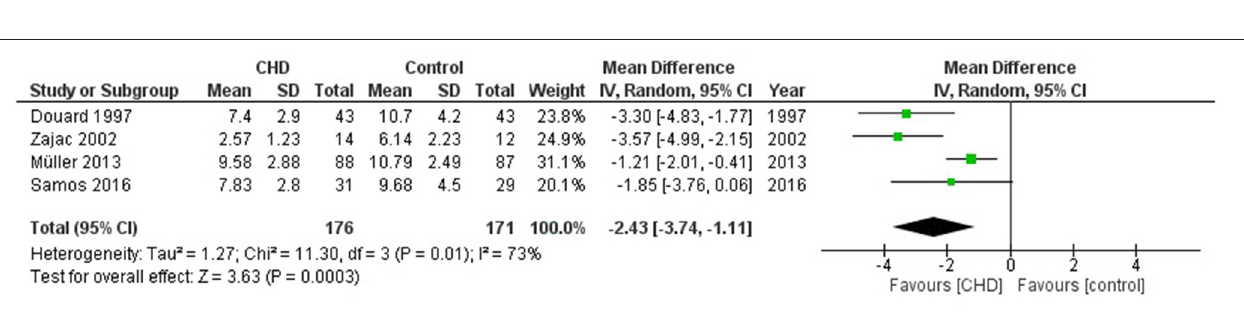
FIGURE 6 | Forest plot for mean ventilatory equivalent for carbon dioxide at anaerobic threshold for CHD in children and adolescents and healthy controls.